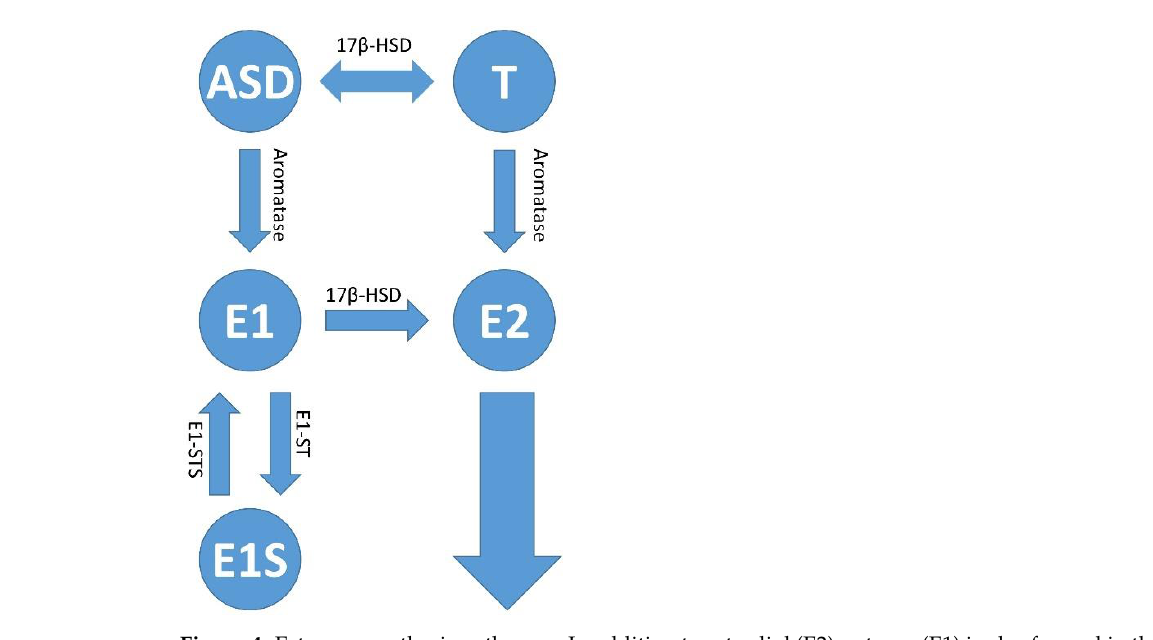
Figure 4. Estrogen synthesis pathways. In addition to estradiol (E2), estrone (E1) is also formed in the human body when androstenedione (ASD) is aromatized. This mainly happens in postmenopausal women. Estrone (E1) and/or estradiol (E2) are delivered to the tumor and its microenvironment via the bloodstream; or there is increased local production and retention of the hormones within the tumors. The latter occurs via increased activity of the cytochrome P450 enzyme, aromatase (CYP19A1), which converts androstenedione (ASD) to E1 and testosterone (T) to E2. The enzymatic activity of estrone (E1) sulfatase converts estrone sulfate (E1S) to estrone (E1); and 17 β -hydroxysteroid dehydrogenase type 1 (17 β -HSD1) activity is responsible for the conversion of E1 to E2, and androstenedione (ASD/AE) to testosterone (T), respectively. The sulfation of estradiol (E2) leads to the inactive form of estrogen, estrogen sulfate (E1S) via the activity of estrone sulfotransfer- ase (E1-ST).